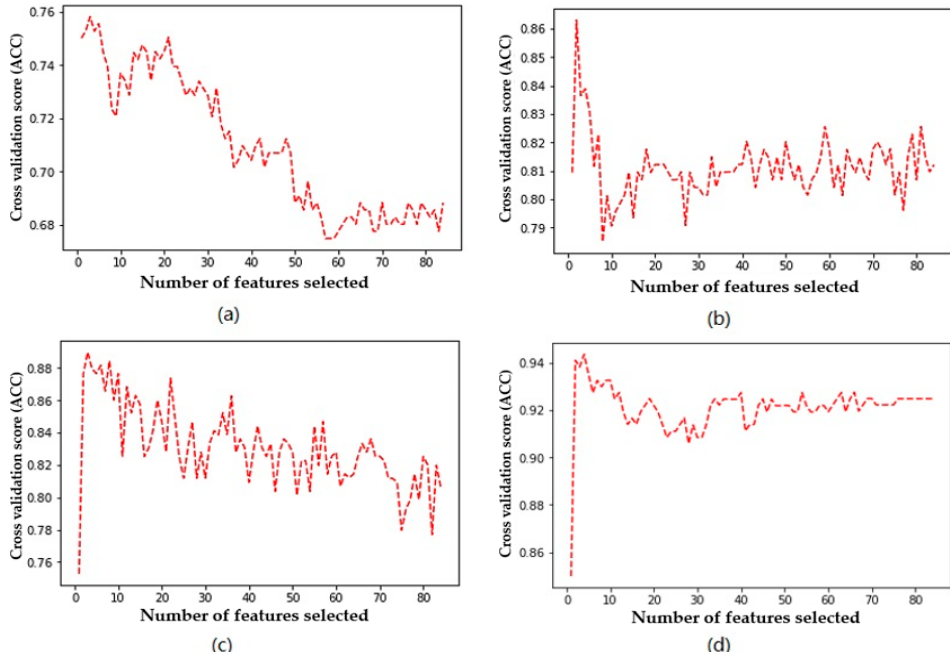
Figure 3. Relationship between accuracy and number of features used by the classifier: ( a ) SVM, ( b ) decision tree, ( c ) RF, ( d ) XGBoost.